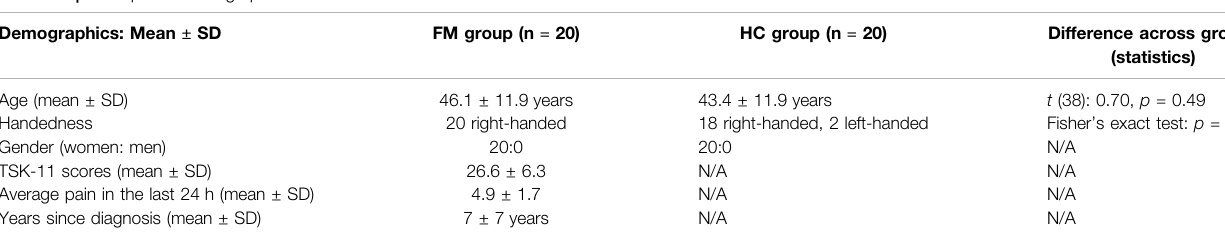
TABLE 1 | Participants ’ demographic